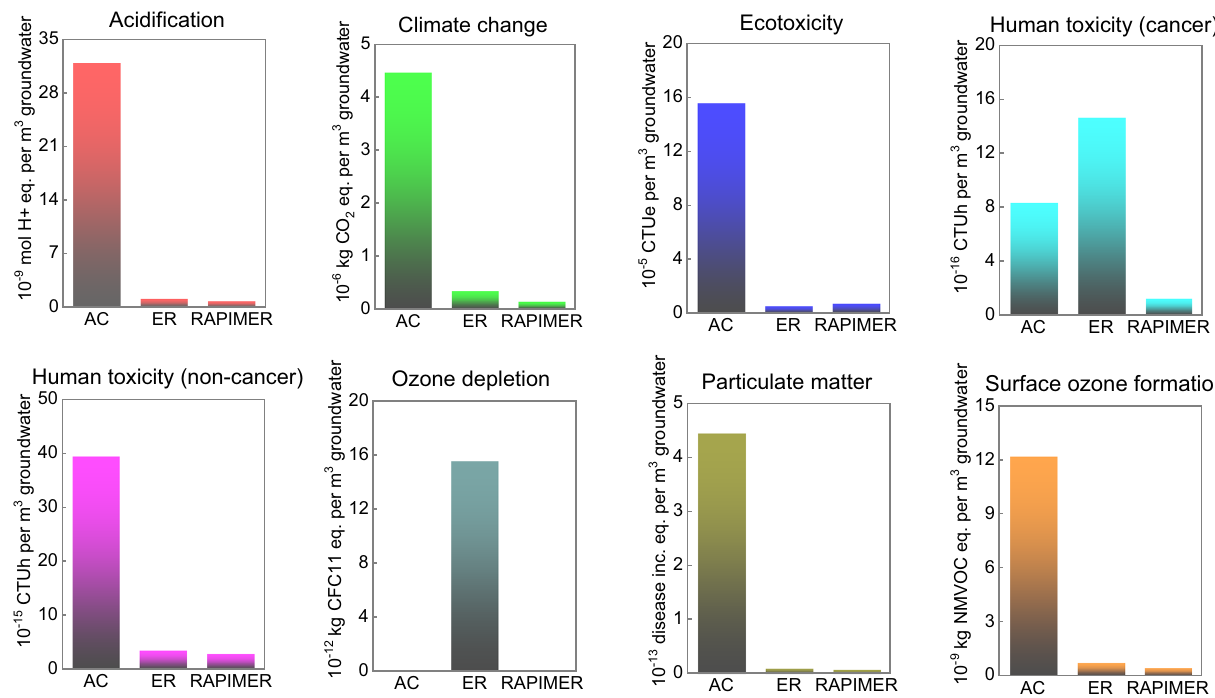
Fig. 6 The environmental impacts of the activated carbon (AC), exchanged resin (ER) and RAPIMER for 1m 3 groundwater treatment. CTUe, comparative toxicity unit for ecotoxicity; CTUh, comparative toxicity unit for human health; CFC-11, (trichloro fl uoromethane) equivalent; NMVOC, non- methane volatile organic